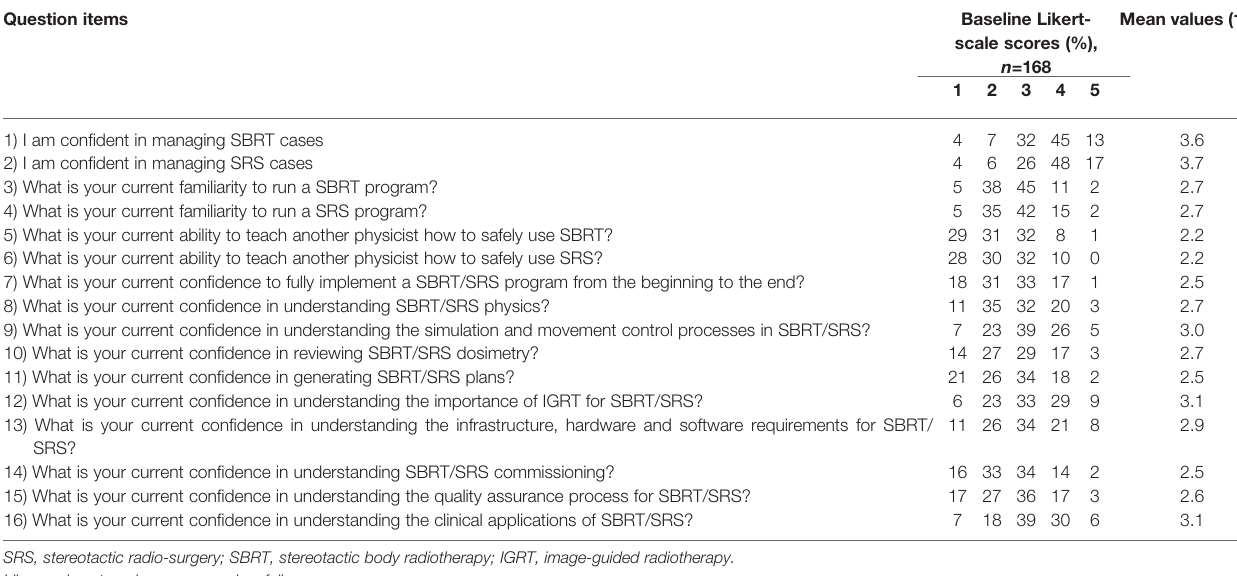
TABLE 2 | Baseline self-con fi dence levels. Question